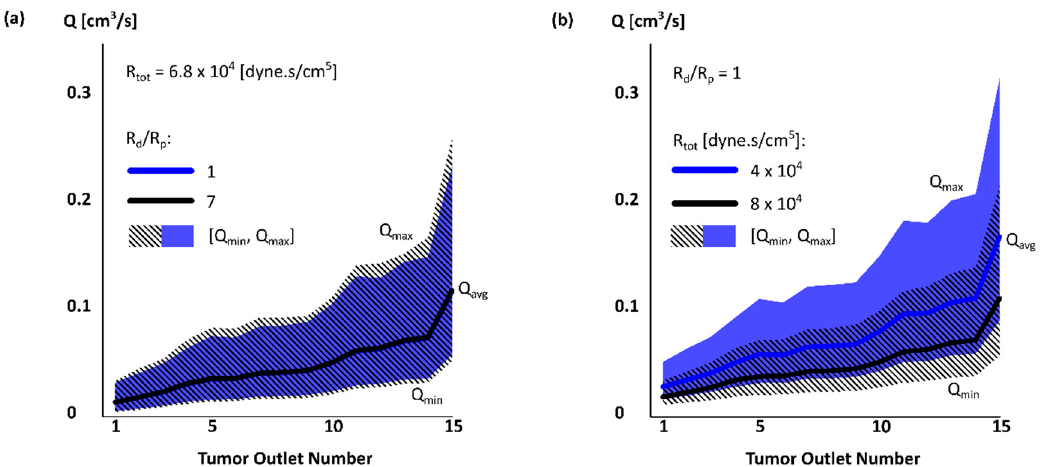
Figure 4. Flow rate Q avg [ Q min , Q max ] in tumor outlets for two simulation cases with ( a ) fixed R tot and varying R d / R p and ( b ) fixed R d / R p and varying R tot .